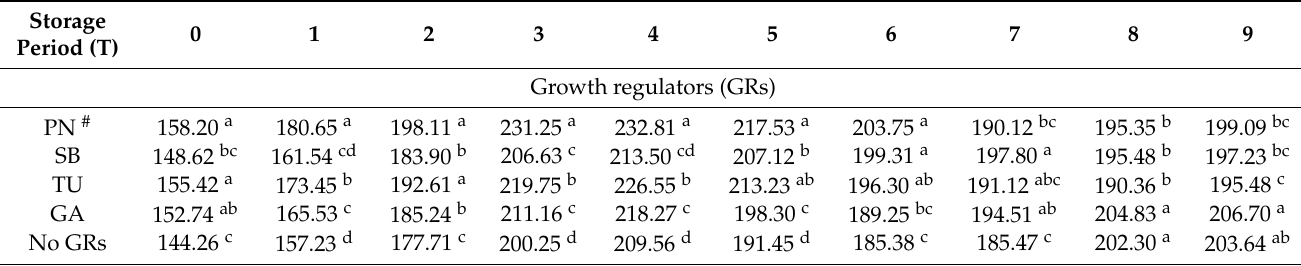
Table 5. Variation in SOD (unit/mg protein) of onions under different GRs and water stress levels during 9 months of